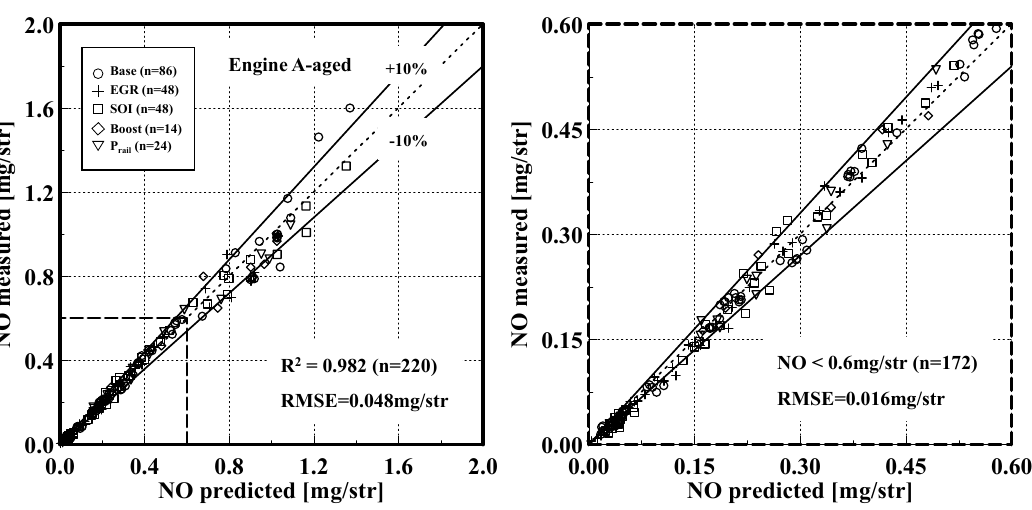
Figure 6. Steady-state NO estimated using the model compared to measured values in engine A-aged. All operating points with parameter variations ( n = 220) and a magnification of relatively small ranges (NO < 0.6 mg/str) are shown.